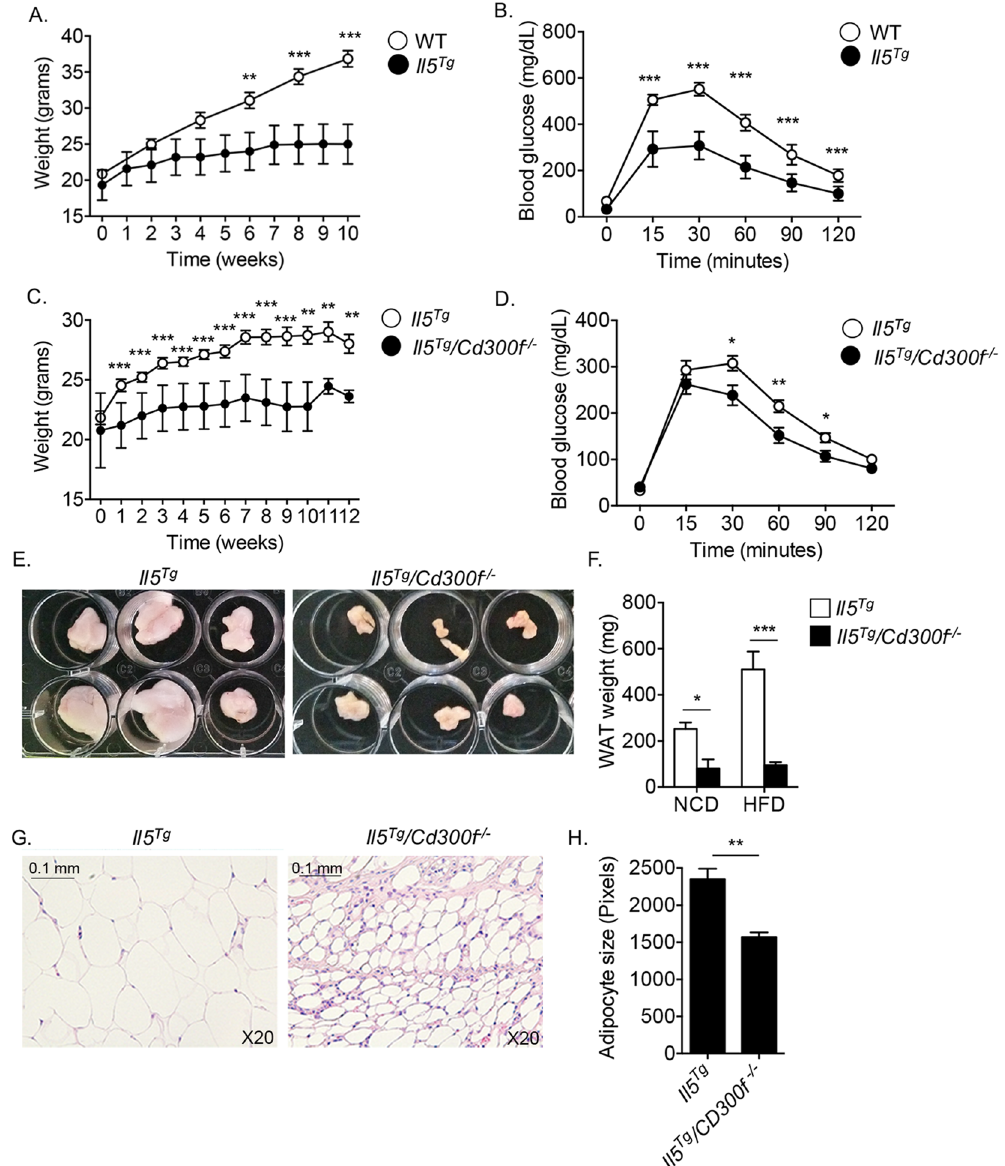
Figure 7. Il5 Tg /CD300f − / − mice are protected from diet-induced weight gain and glucose intolerance. Wild type (WT), Il5 Tg and Il5 Tg /CD300f − / − mice were fed with high fat diet (HFD) for up to 12 weeks and their weight was monitored at the indicated time points ( A , C ). After ten ( B ) and twelve ( D ) weeks of HFD, the mice underwent glucose tolerance test ( B , D ). Il5 Tg and Il5 Tg /CD300f − / − mice were fed with NCD or HFD for twelve weeks. Thereafter, the white adipose tissue (WAT) was obtained, photographed ( E ) and weighed ( F ). In addition, adipocyte size was assessed in H&E stained slides ( G – H ). Data in ( A–D ) are representative of n = 12; in ( E and G ) photographs are representative of 6/12 mice; In ( F and H ), n = 14; * p < 0.05, ** p < 0.01, *** p < 0.001 as analyzed by two-way ANOVA followed by Tukey post-hoc test ( A – D ) and Student’s t-test ( F – H